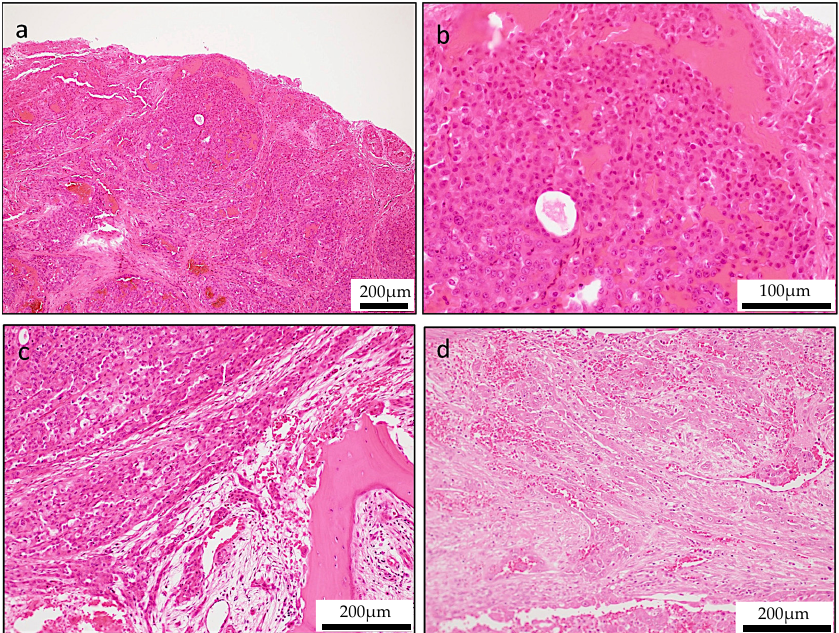
Figure 3. Unusual histologic features of secretory carcinoma (SC). ( a , b ) Solid growth pattern with high-grade cellular features (a; low-magnification, b; high-magnification,). ( c ) Bone destruction feature. ( d ) Lymphovascular invasion findings.